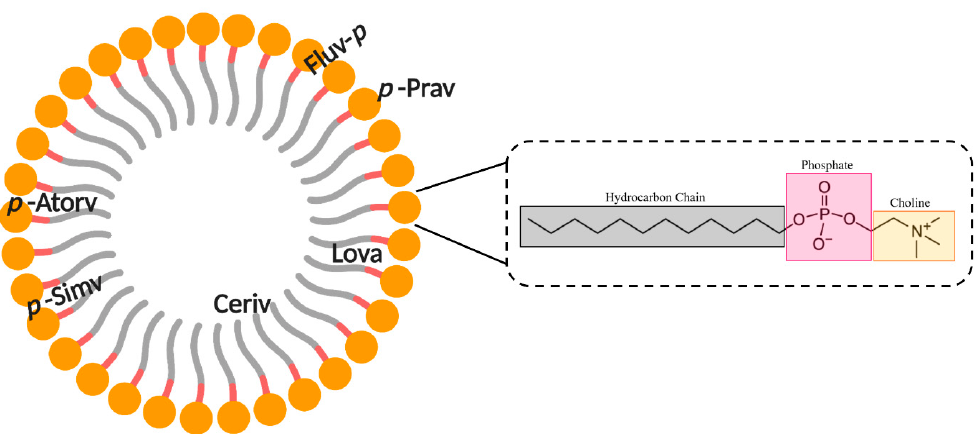
Figure 5. Schematic representation of dodecyl phosphocholine (DPC) micelle with approximate binding locations of statins (atorvastatin, cerivastatin, fluvastatin, lovastatin, pravastatin, and